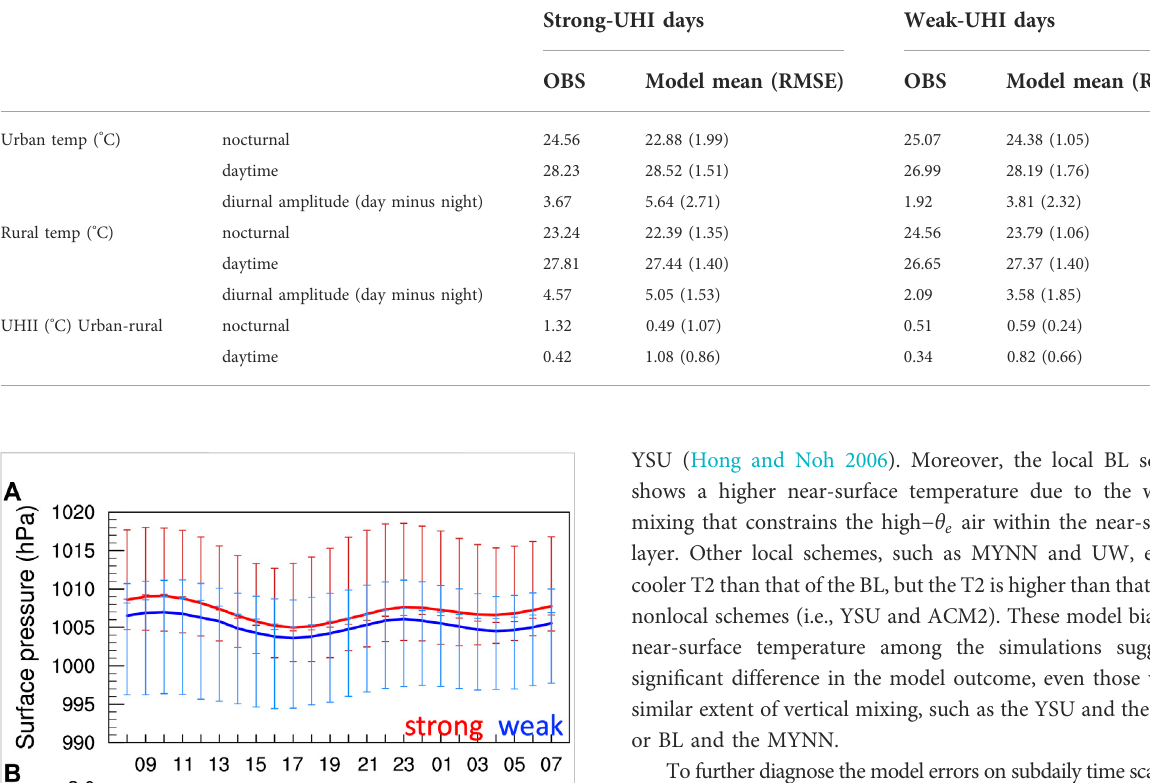
TABLE 2 Statistics of observed (OBS) and modeled surface air temperature (T2) over urban and rural regions on strong and weak-UHI days. The “ Nocturnal ” values are calculated by the hourly T2 mean from 2000 LST to 0700 LST, while the “ daytime ” values are obtained from the T2 mean from 0800 LST to 1900 LST. The model means are the arithmetic means of the outputs from the seven PBL schemes.